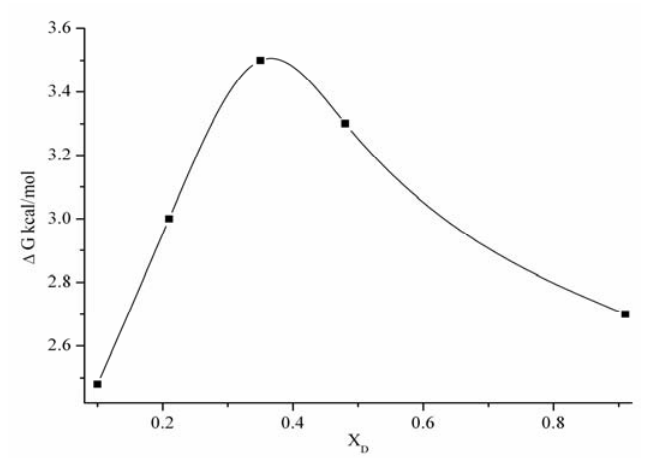
Figure 2. Free energy change of activation via water-DMSO solutions vs. mole